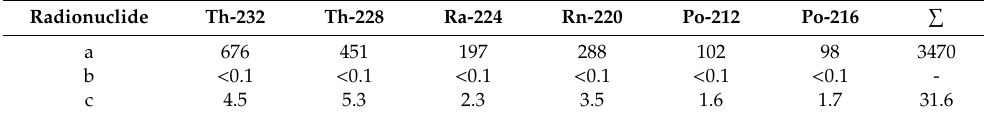
Table 3. Activity (kBq / kg) determined by alpha spectrometry of the samples: (a) precipitation of oxide and hydrated rare-earth elements (REEs), uranium and thorium compounds obtained after autoclave processing of monazite concentrate; (b) phosphate-alkaline solutions and wash water; (c) nitric acid solution obtained by dissolving oxide and hydrated sediments of REEs, uranium and thorium.